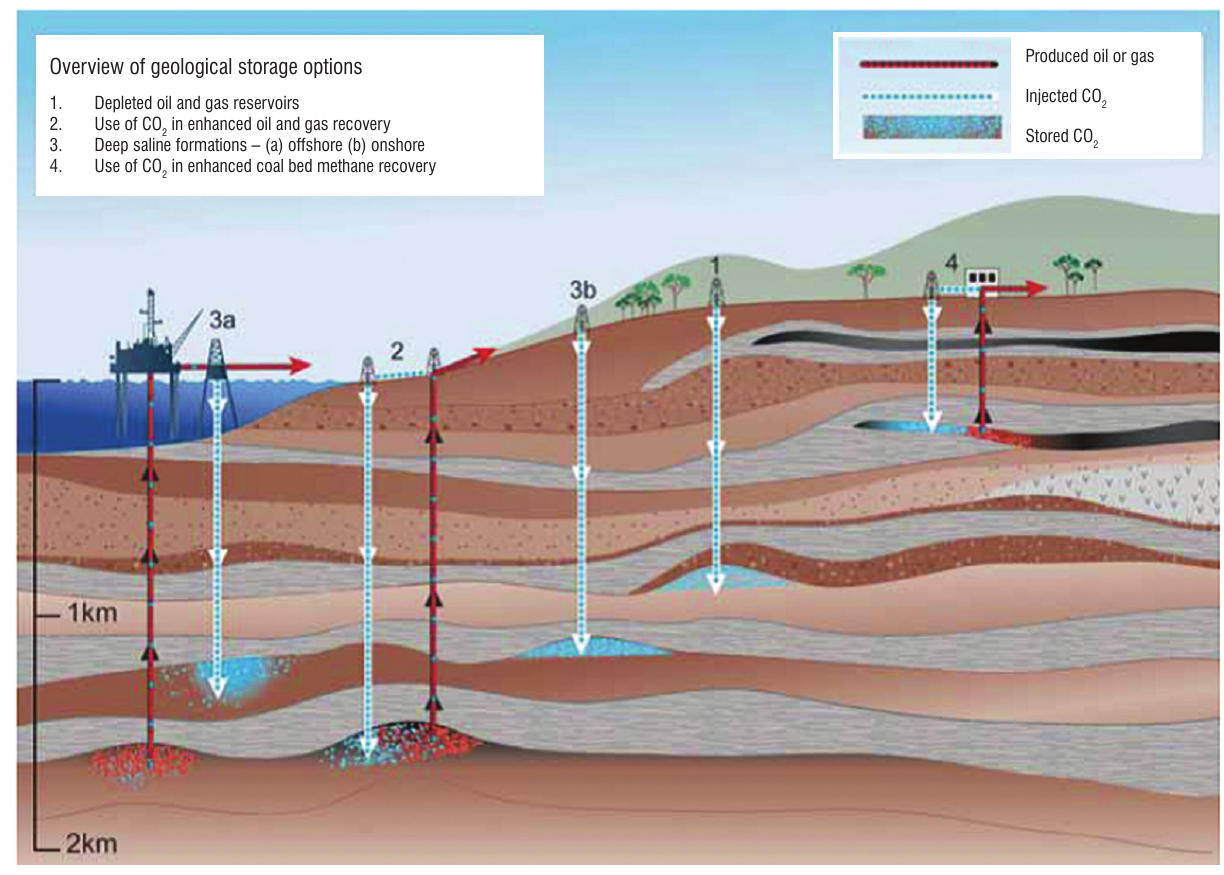
Figure 17: Geological storage options.